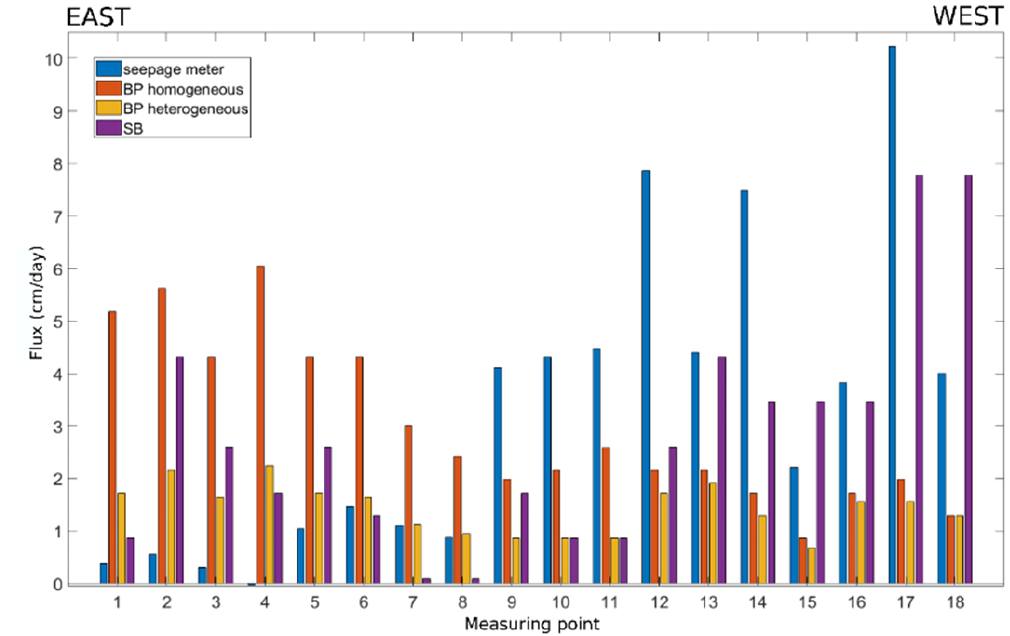
Figure 8. The mean of exchange fluxes measured with seepage meters and calculated using analytical solutions for temperature profiles.